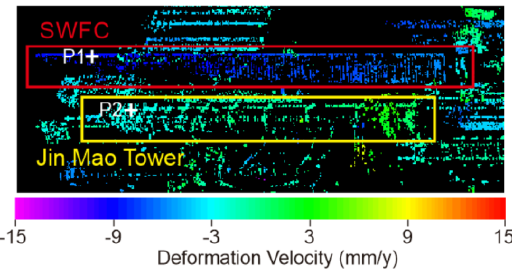
Figure 6. Deformation velocity map of the two skyscrapers in Shanghai Lujiazui Zone estimated by the Tomo-PSInSAR. The red rectangle in the top figure denotes SWFC, and the yellow rectangle denotes Jin Mao Tower.